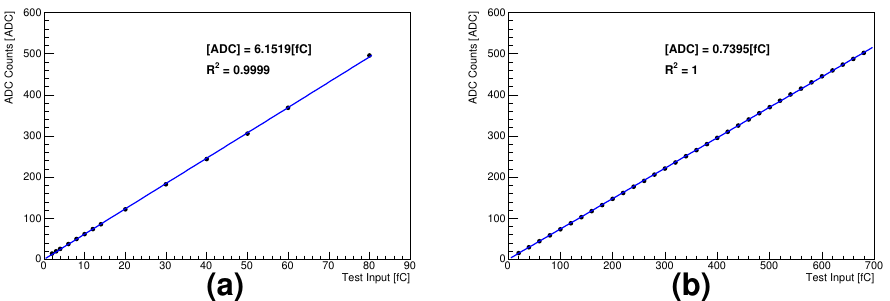
Figure 5. Linearity Between Test Pulse and ADC: ( a ) High Gain and ( b ) Low Gain.